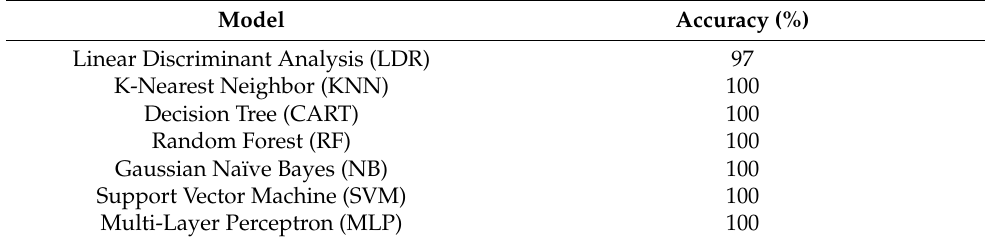
Table 3. Accuracy of fault prediction for different ML models.